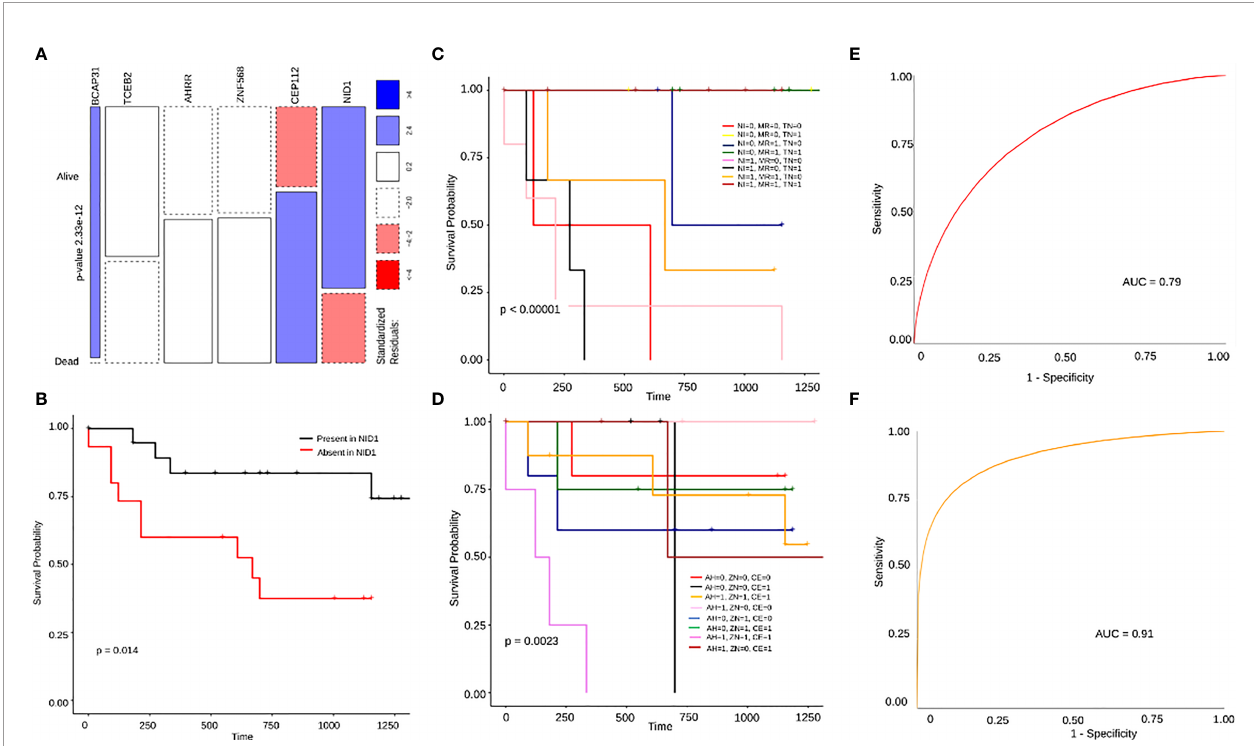
FIGURE 6 | (A) A mosaic plot for chi square test showing signi fi cant difference between the number of alive and dead patients harboring mutations in BCAP31, TCEB2, AHRR, ZNF568, CEP112 and NID1. (B) A Kaplan Meier plot showing signi fi cant difference in survival probability between patients with and without NID1 mutation. (C, D) Are differential survival plots for the 3 dead and 3 alive gene signatures respectively. In (C) AH stands for AHRR, ZN stands for ZNF568 and CE stands for CEP112 where the difference in survival probabilities is much more signi fi cant with p=0.0023. In (D) NI stands for NID1, MR stands for MRPL23, and TN stands for TNS2, and the difference in survival between presence of mutations in different combinations of genes is signi fi cant with p<0.0001. (E) This is an ROC curve representing the 3 gene dead signature model with a high accuracy of 79% (AUC=0.79). (F) An ROC curve representing the 3 gene alive signature model with an even higher accuracy of 91%